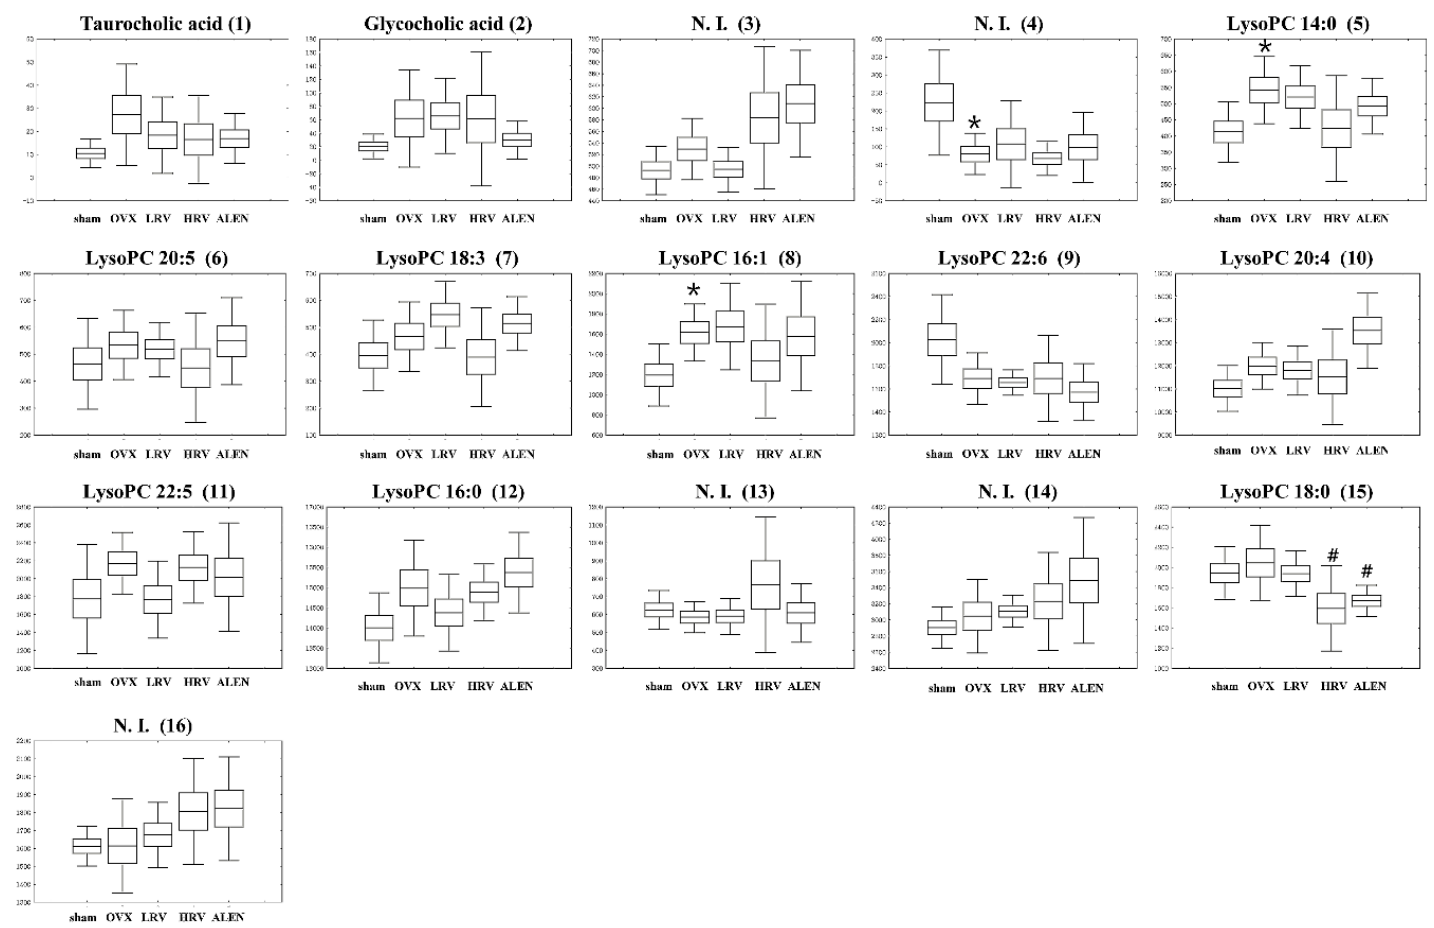
Figure 5. Box and whisker plots analyzed by UPLC-Q-TOF-MS of the five different rat groups. The results are the mean ± SD of triplicates from a representative experiment. sham, sham-operated control; OVX, ovariectomized rat without treatment; LRV, ovariectomized rat treated with low-dose RC vinegar; HRV, ovariectomized rat treated with high-dose RC vinegar; ALEN, ovariectomized rat treated with alendronate. * p < 0.05 compared to the sham, # p < 0.05 compared to the OVX group.